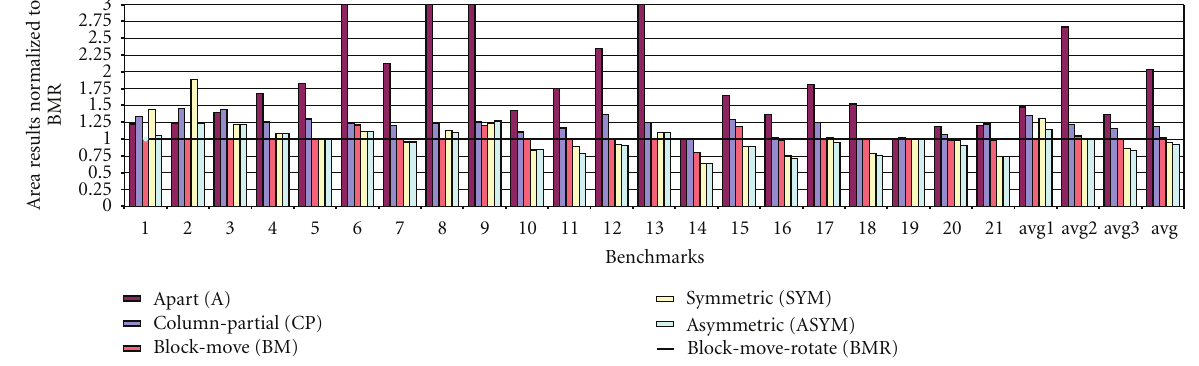
Figure 12: Area comparison between di ff erent techniques of mesh- and tree-based